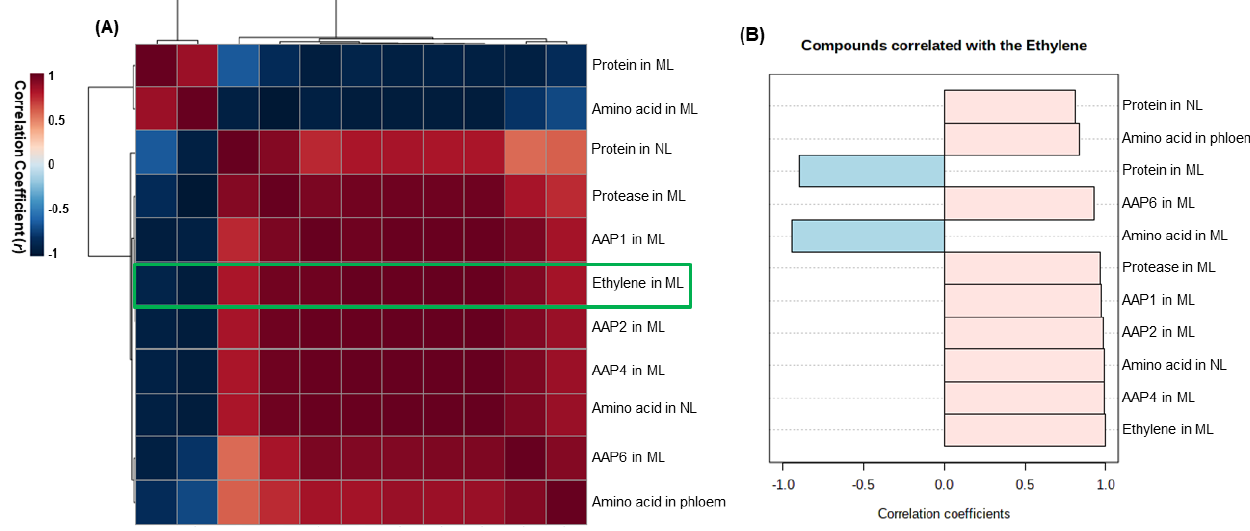
Figure 5. Heatmap of the overall correlations among the variables measured at day 10. ( A ) Heatmap responses of Pearson’s correlation coefficient ( r ) for the identified metabolites or gene expression levels measured in 100 ppm ethephon − treated or control plants. Red indicates positive effect, whereas blue indicates negative effect. ( B ) The factors correlated with ethylene. ML, mature leaves; NL, newly formed